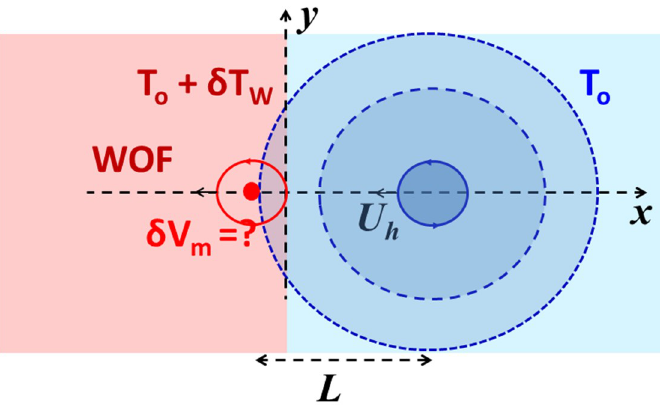
Figure 1. A tropical cyclone (TC) translates westward at a constant U h across x = 0 onto a warm ocean feature (WOF) where SST increases by δT W . The circles depict the TC wind from weak, e.g., 18 m/s in the outer circle of radius L to the maximum in the inner‐most 'core'. As the storm approaches, wind at the redpoint strengthens from weak to the maximum over a time ~ L/U h shortly after the storm crosses into the WOF. The goal is to calculate the increased wind δV m due to the coupled response of the WOF and ocean cooling.